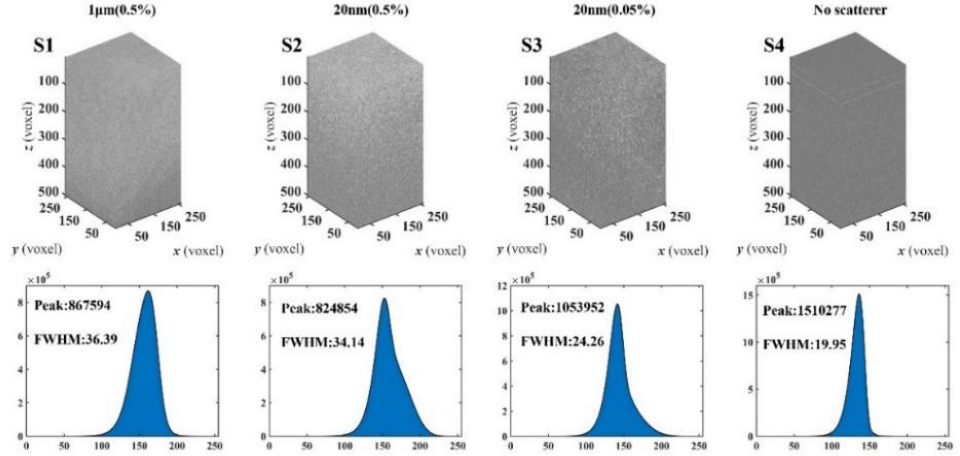
Figure 9. Three-dimensional OCT images of silica gel phantoms with different sizes and mass fractions of scatterers and their corresponding histograms of phantoms. S1: 1 µ m (0.5%), S2: 20 nm (0.5%), S3: 20 nm (0.05%), S4: No